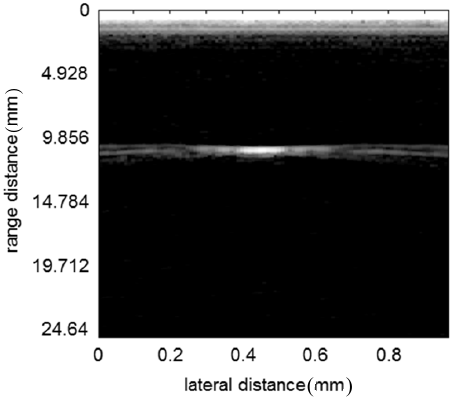
Figure 3. B-mode image of a stainless wire at 15 µ m in diameter.